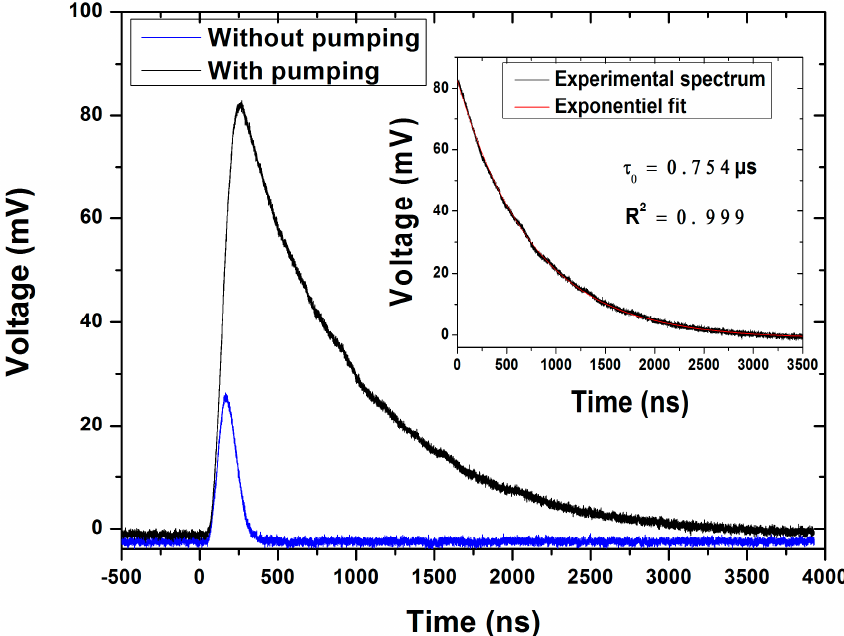
Figure 3. Ring-down decay recorded at a wavelength of 6.80 µm for the pumped empty cavity composed of a 50-cm-long optical cavity and mirrors with reflectivity of 99.77% (black) and a cavity with an atmospheric pressure of air (blue). The inset shows the fitted exponential decay curve of the pumped empty cavity.